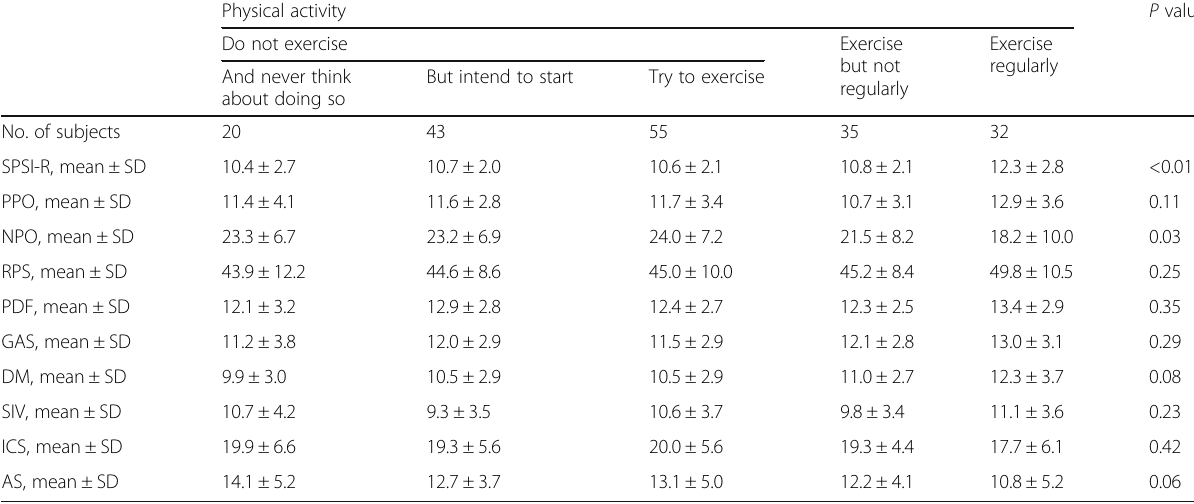
Table 2 Differences in SPSI-R and subscales among categories of physical